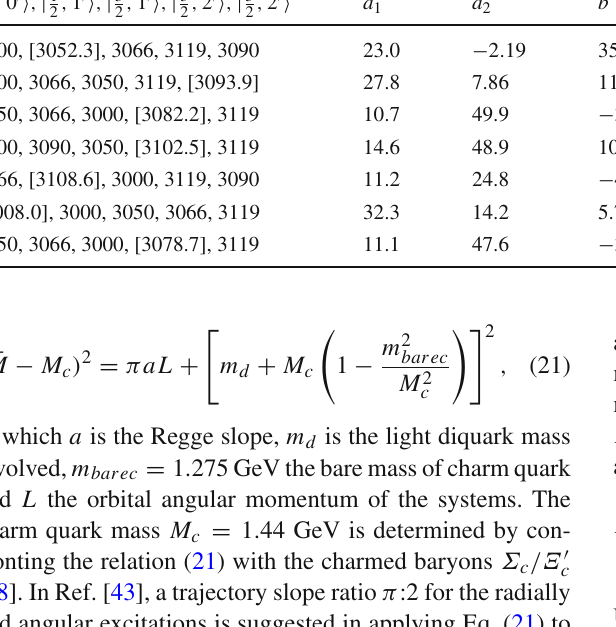
Table 2 Mass and parameters for two J P assignments (13) and the alternative arrangement of four LHCb-observed masses of the excited Ω ∗ 5 = 10 possible choices of mass inputs out of the c systems. All 2